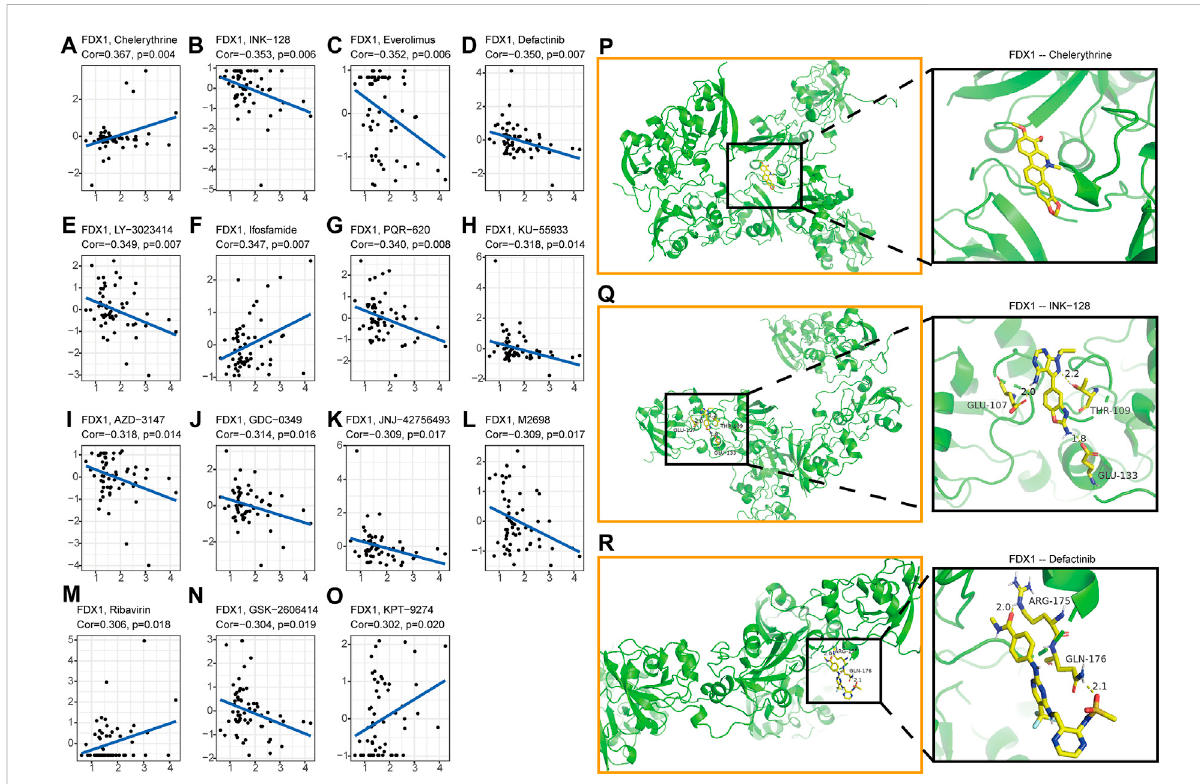
FIGURE 9 Analysis of FDX1 Expression and Sensitivity of Tumor Chemotherapeutics (A) Chelerythrine (B) INK-128 (C) Everolimus (D) Defactinib (E) LY- 3023414 (F) Ifosfamide (G) PQR-620 (H) KU-55933 (I) AZD-3147 (J) GDC-0349 (K) JNJ-42756,493 (L) M2698 (M) Ribavirin (N) GSK-2606414 (O) KPT- 9274. The X -axis represents the gene expression level of FDX1, and the Y -axis represents the z scores of Compound activity. Molecular docking results of protein FDX1 (3P1M) with Chelerythrine (P) , INK-128 (Q) and Defactinib (R) . No hydrogen bond was found between FDX1 and Chelerythrine,buttherewasastablebindingenergy.Therearethreehydrogenbondsof2.0,2.2and1.8 ÅinthedockingbetweenFDX1andINK-128. The docking results of FDX1 and Defactinib showed two hydrogen bonds of 2.0 and 2.1 Å